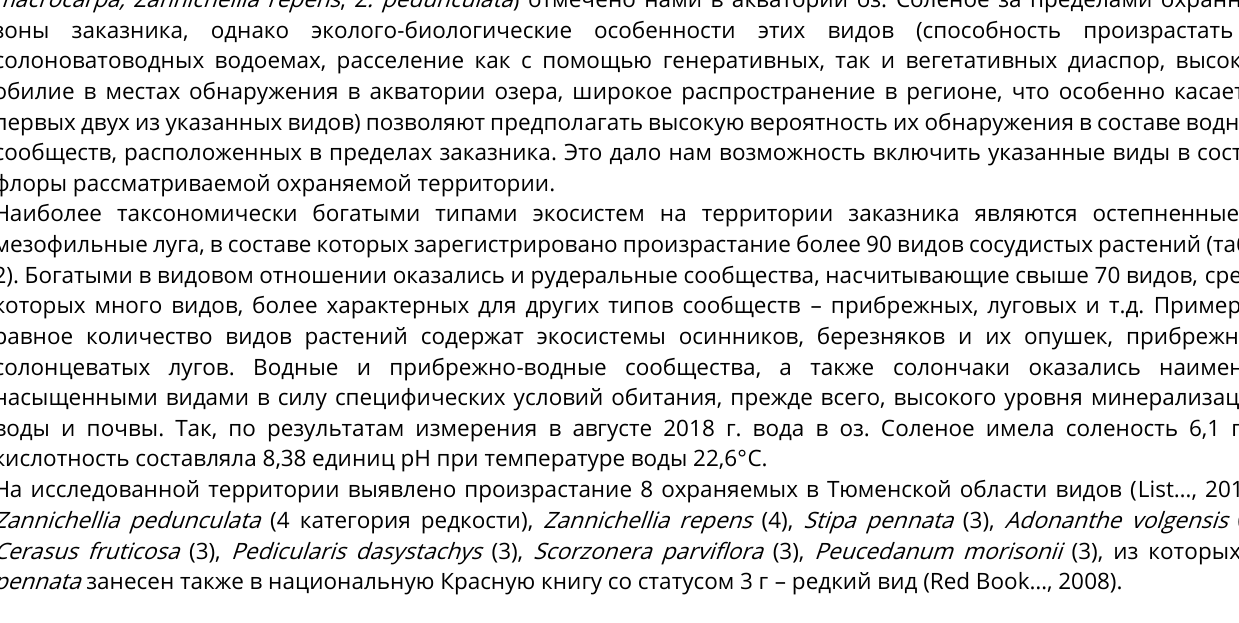
a б Рис. 2. Типичная (а) и белоцветковая (б) формы Lathyrus tuberosus L. на острове Таволжан (Тюменская область). Fig. 2. Typical (a) and white-flowered (b) forms of Lathyrus tuberosus L. on the island of Tavolzhan (Tyumen Region). Необходимо указать, что произрастание четырех видов водных растений (Potamogeton perfoliatus, Stuckenia macrocarpa, Zannichellia repens, Z. pedunculata) отмечено нами в акватории оз. Соленое за пределами охранной